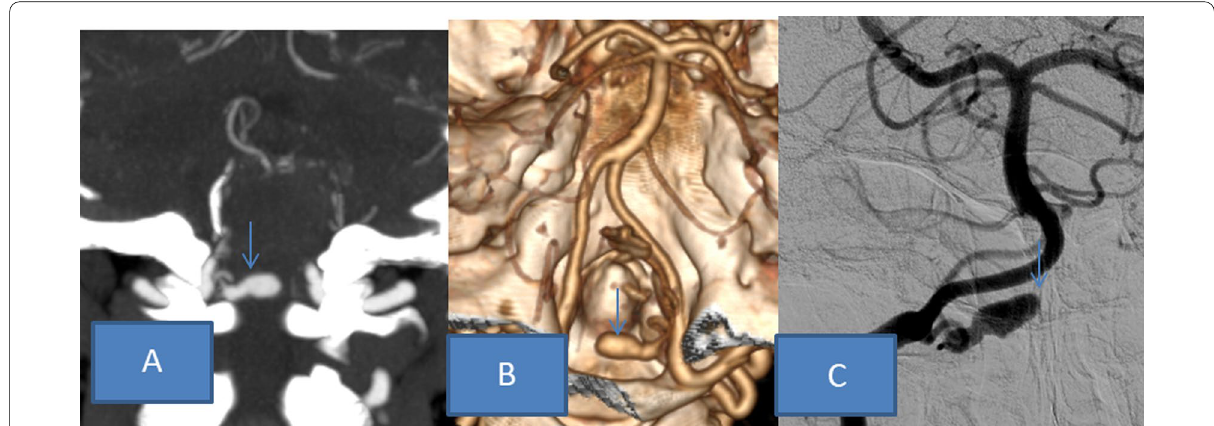
Fig. 1 Right posterior inferior cerebellar artery (PICA) aneurysm; a Coronal MIP image, b volume reconstructed image (VRI), c DSA image in AP view, of the same patient showing aneurysm in the proximal part of PICA just after its origin (arrow pointing towards aneurysm)